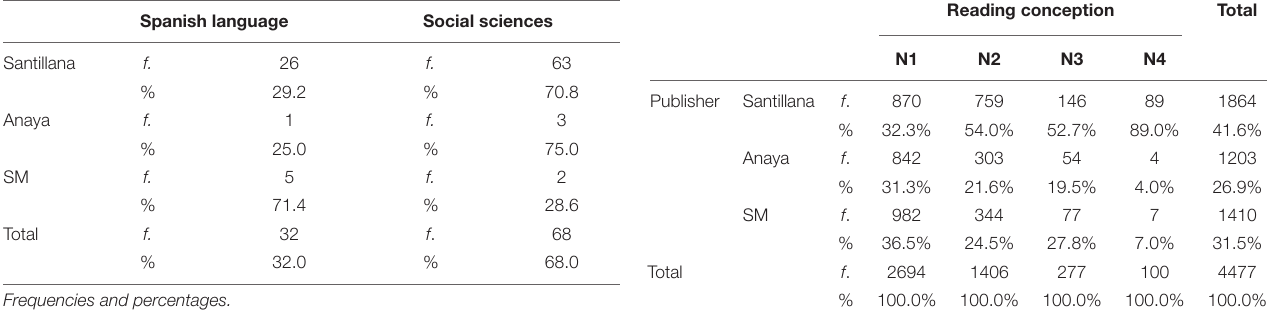
TABLE 8 | Contingency table for the variables publishing house and reading